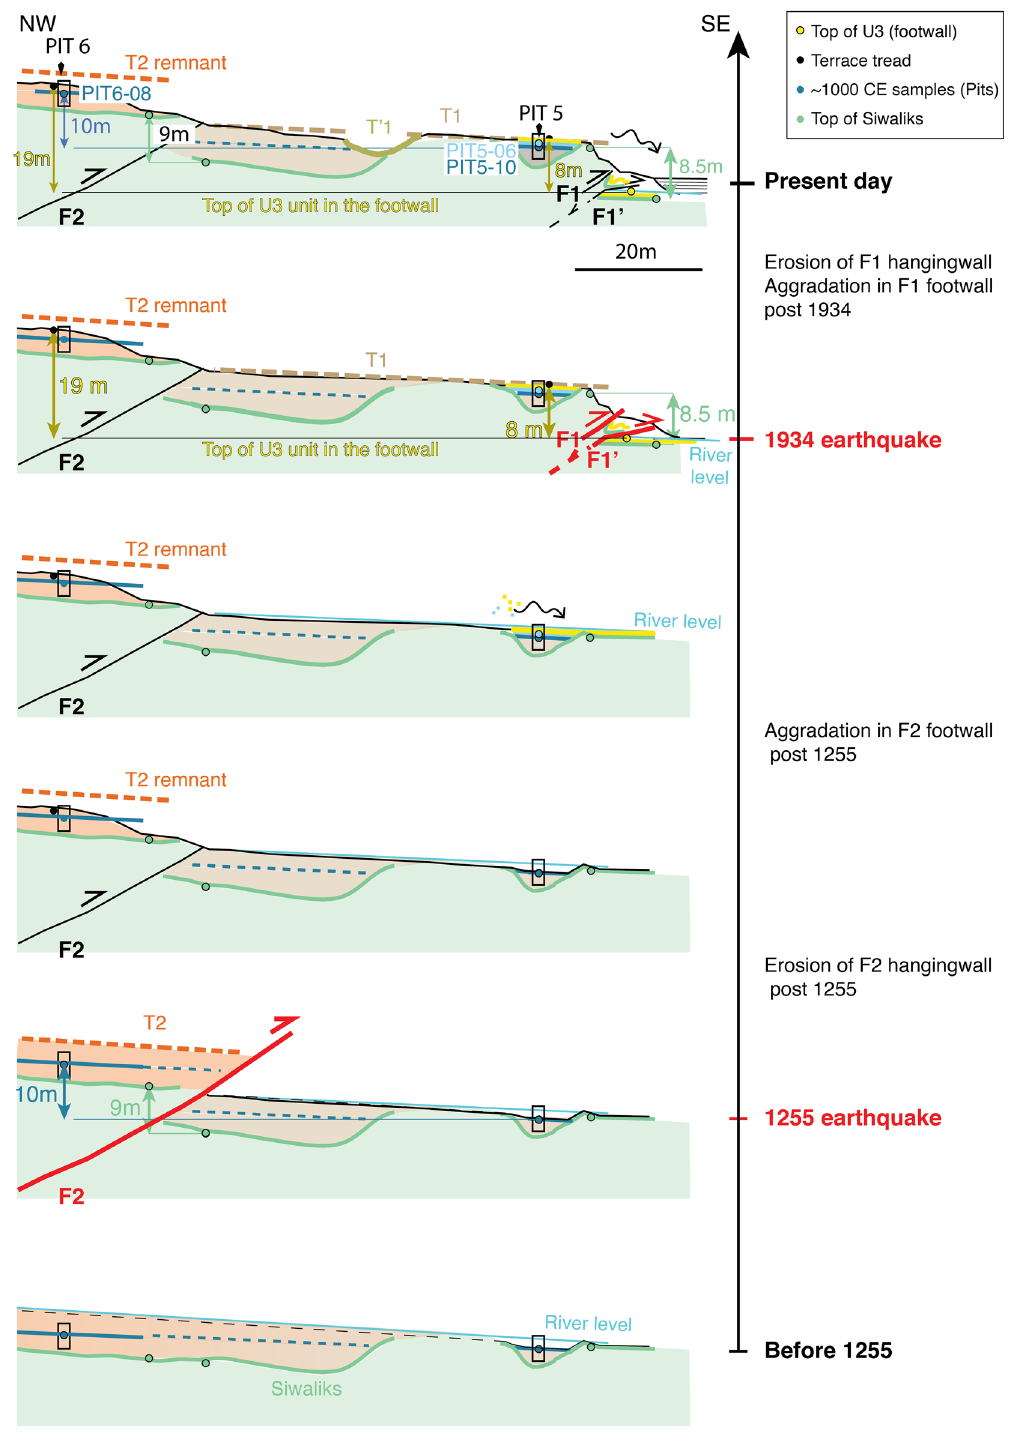
Figure 8. Schematic view of the chronological evolution of the Khutti Khola